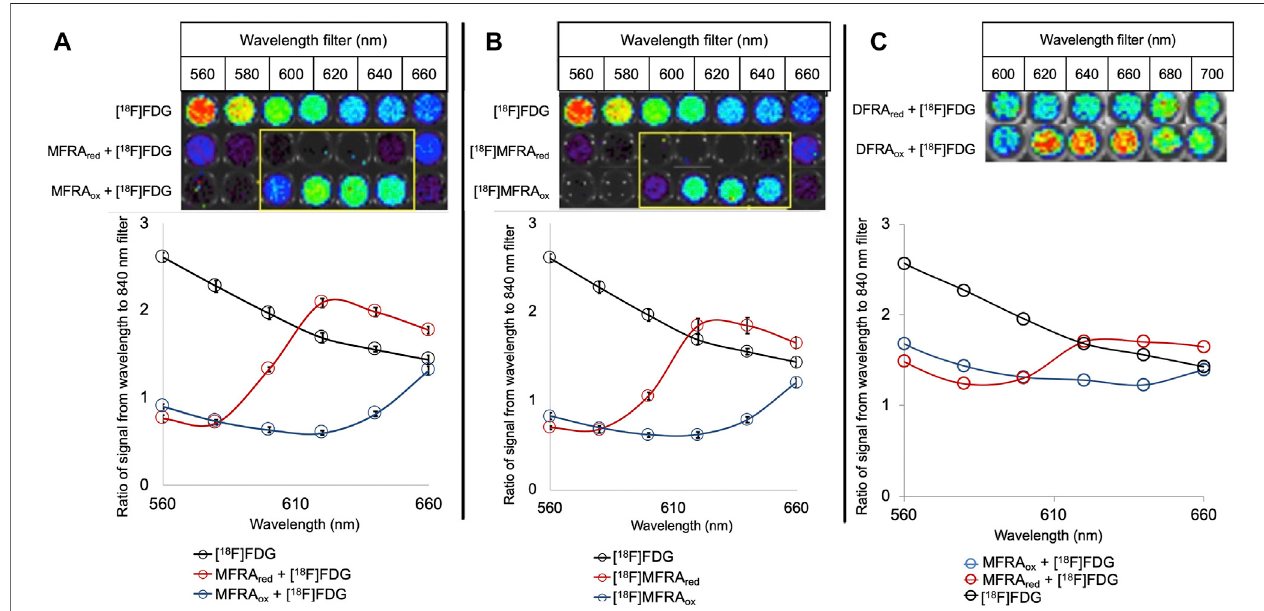
FIGURE 1 | Intermolecular (A) and intramolecular (B) effects of MFRA ox and MFRA red and intermolecular (C) effect of DFRA and DFRA red on Cerenkov radiation: Cerenkov images are shown on top, the graphs below show the quanti fi cation of the signal relative to the emission at 840 nm ( n (cid:2) 4). At each wavelength, an 18 F-FDG control shows the expected emission of Cerenkov radiation as avisual point of reference. In the 19 F-MFRA mixed with 18 F-FDG (A) and 18 F-MFRA (B) , an attenuation of the Cerenkov signal is observed in the 560 – 660 nm fi lters. After reduction with sodium dithionite, attenuation of the Cerenkov signal is still detected in the 560 – 580 nm fi lters, both inter- and intramolecularly. In fi lters 600 – 660 nm, an increase in signal is detected when compared to the oxidized probe due to CRET, fl uorescence emission of absorbed Cerenkov light. The CRET emission peaks at 620 nm with a 4:1 ratio of reduced to oxidized signal. DFRA (Error bars (cid:2) standard deviation) (C) attenuates Cerenkov signal between the 600 – 660 nm fi lters. CRET from DFRA red increases the detected signal in the 620 – 660 nm fi lters ( n (cid:2) 1). The ratio of DFRA red :DFRA peaks at 1.4:1 in both the 620 and 640 nm fi